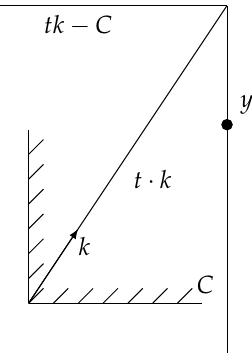
Figure 1. Illustration of the functional z C , k ( y ) : = inf { t ∈ R | y ∈ tk − C }